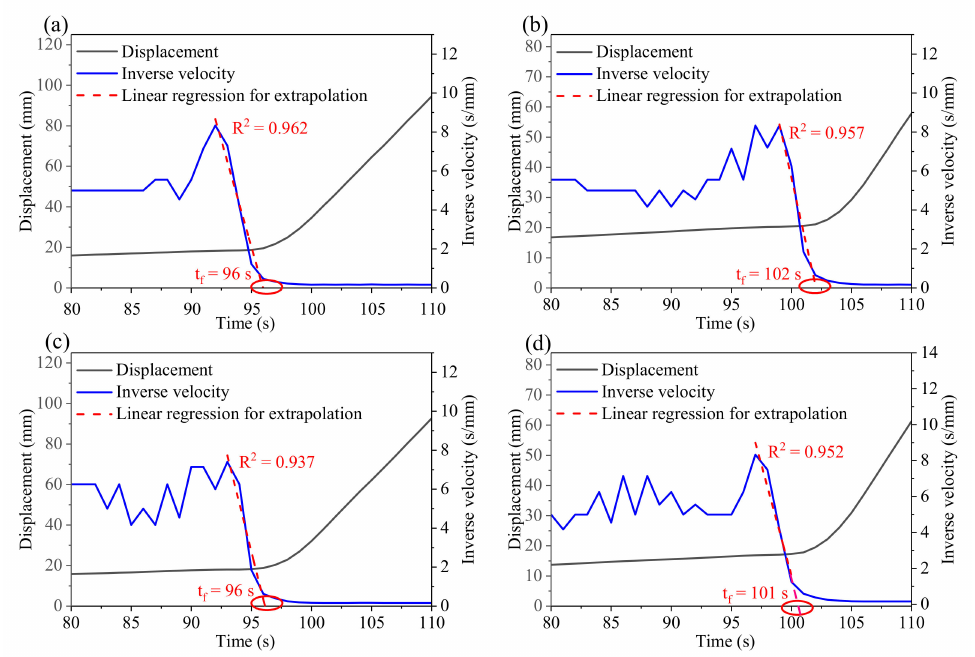
Figure 8. Displacement and inverse velocity plotted against time (80–110 s) in ( a – d ) for the four experiments. All data points are the average value of 1